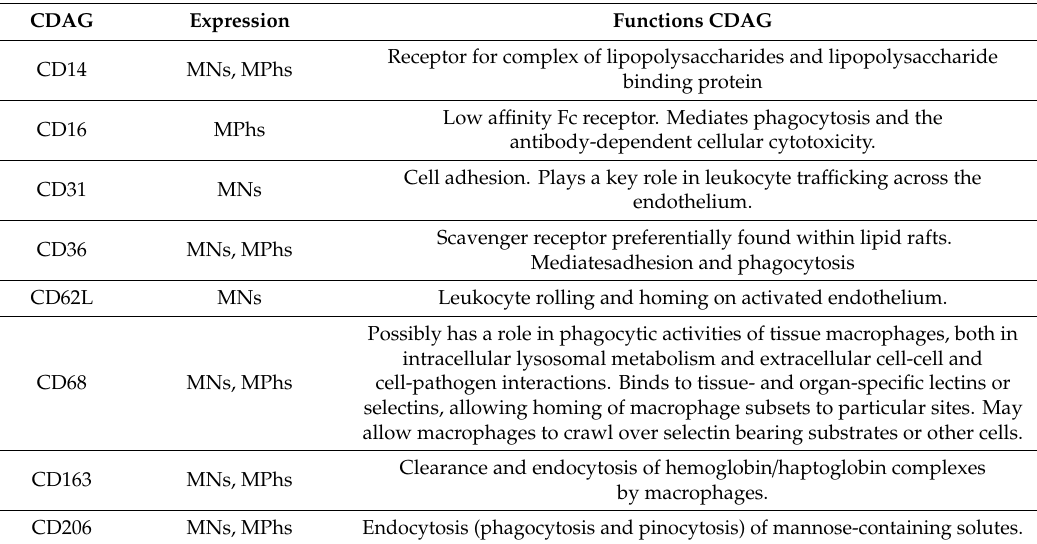
Table 1. Functions of CD antigens